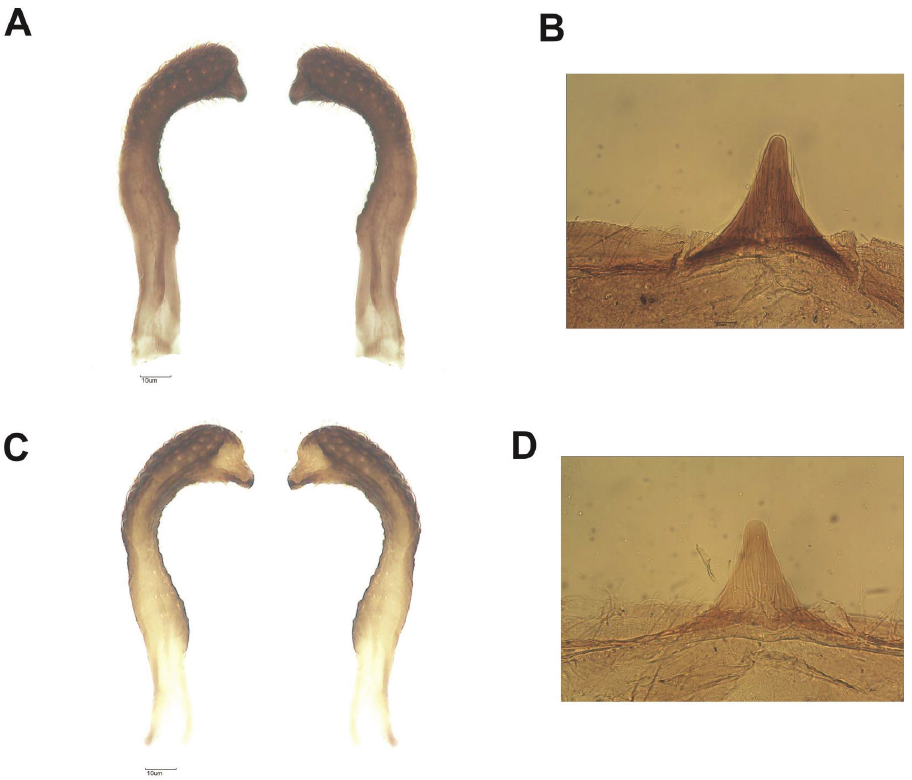
Figure 9. Parameres dorsal view of R. taquarussuensis sp. n . ( A ), Median process of the pygophore of R. taquarussuensis sp. n. ( B ) Parameres dorsal view of R. neglectus ( C ) Median process of the pygophore of R. neglectus ( D